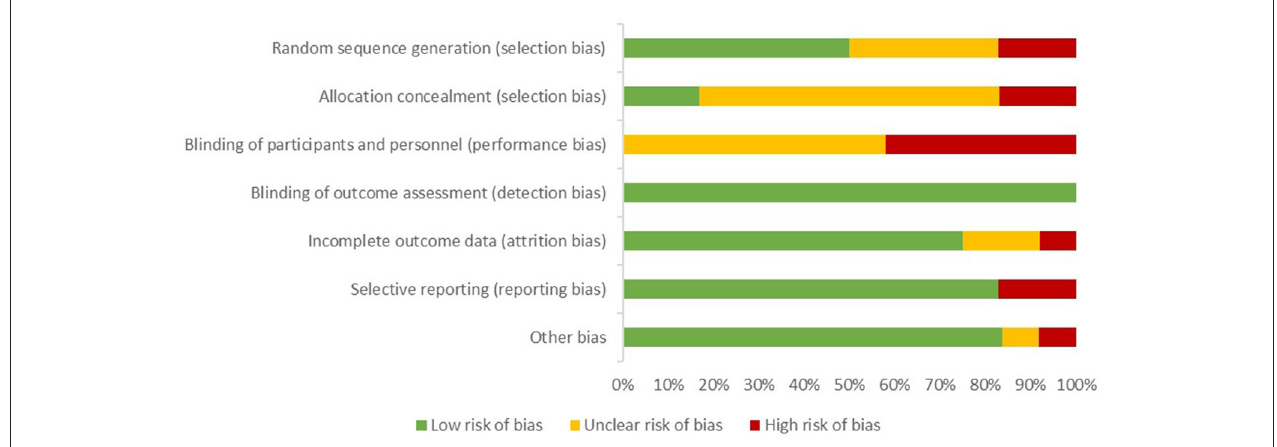
FIGURE 2 | Proportion of studies with a given risk of bias among 12 trials included in a systematic review comparing selective dry cow therapy and blanket dry cow